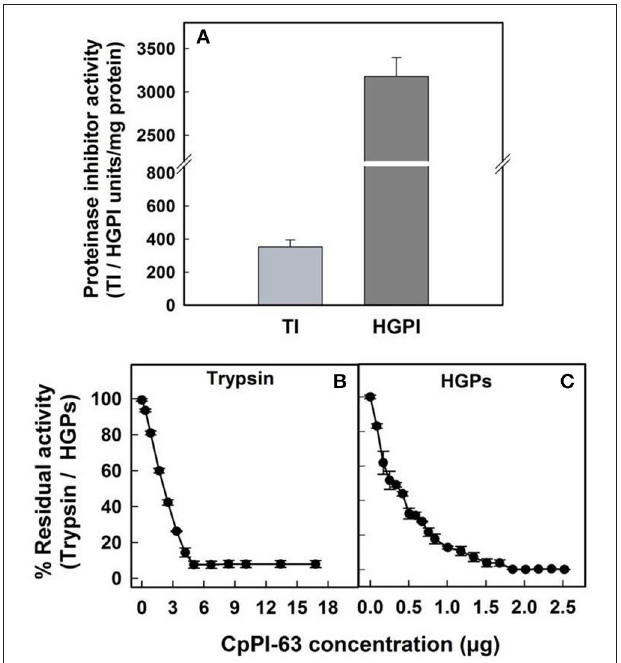
FIGURE 4 | Evaluation of inhibitory activity of CpPI 63 against HGPs. The specific activities of CpPI 63 against bovine pancreatic trypsin and HGPs (A) ; half maximal inhibitory concentrations (IC 50 ) of CpPI 63 against (B) bovine pancreatic trypsin and (C) HGPs. The experiments were conducted three times, each with three replications and the mean ± S.E was reported.